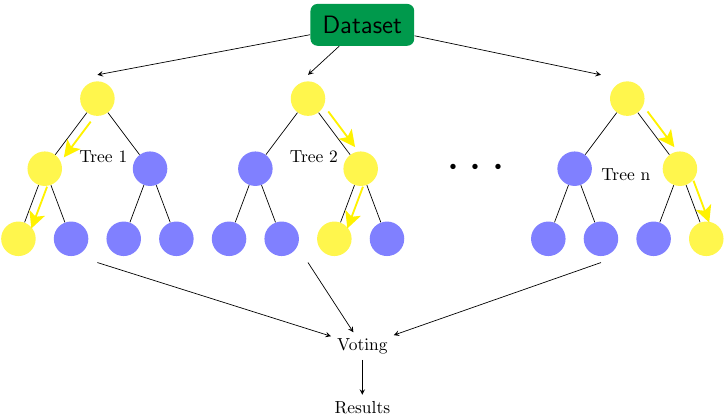
Figure 5. Random Forest model prediction